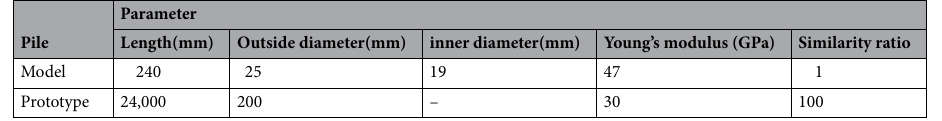
Table 5. Characteristics of model and prototype.